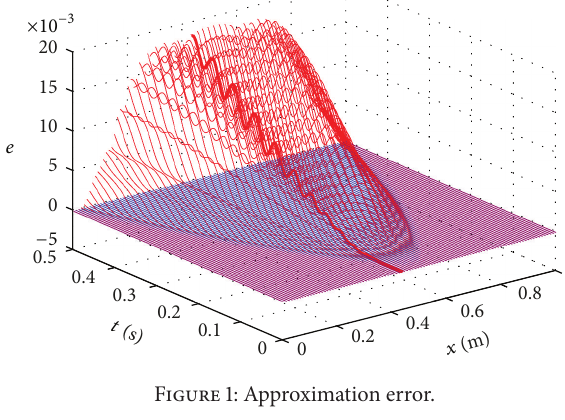
Figure 1: Approximation error.